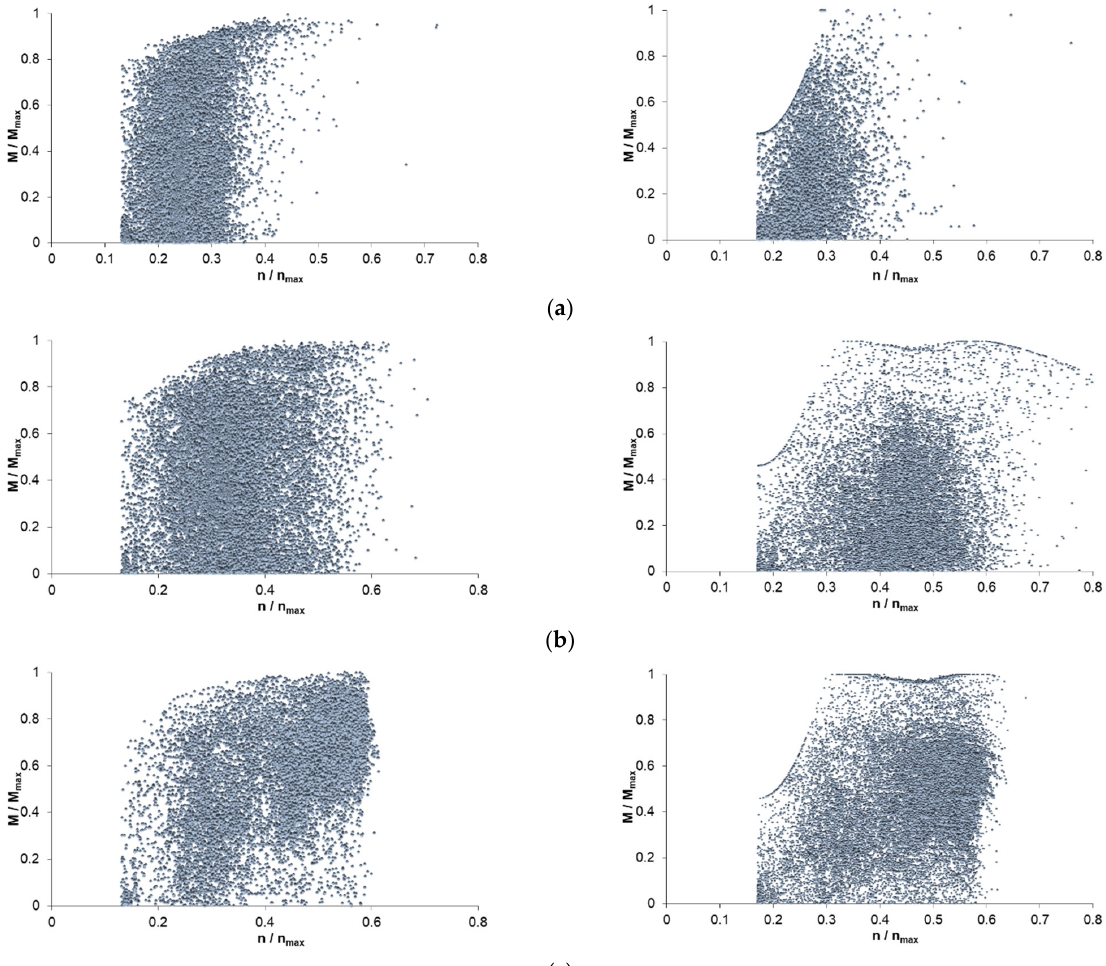
Figure 3. Area of the engine operating points recorded in real traffic during driving on different roads for Vehicle 1 (on the right side) and Vehicle 2 (on the left side) ( a ) city roads, ( b ) rural roads, ( c ) motorways.